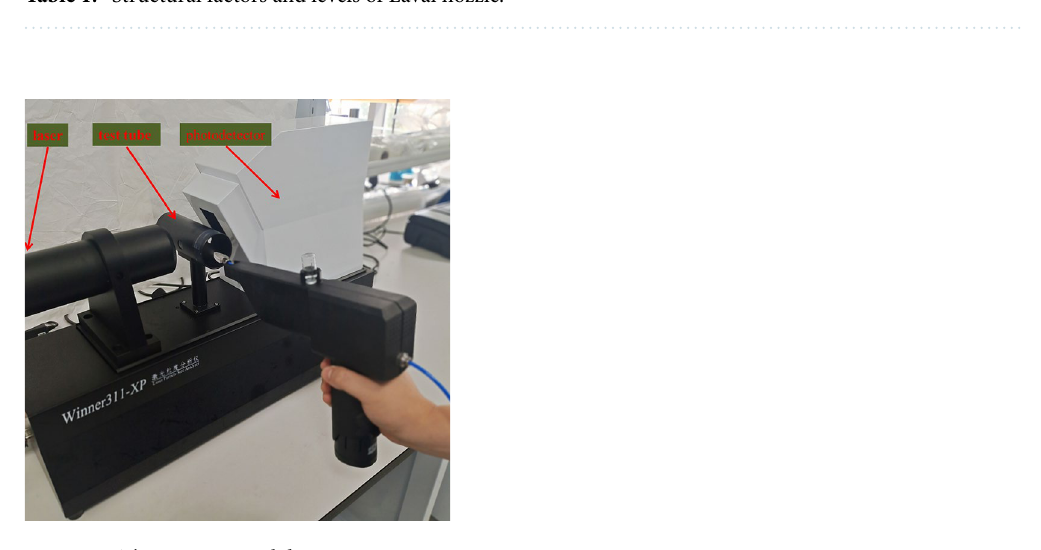
Figure 2. The experimental